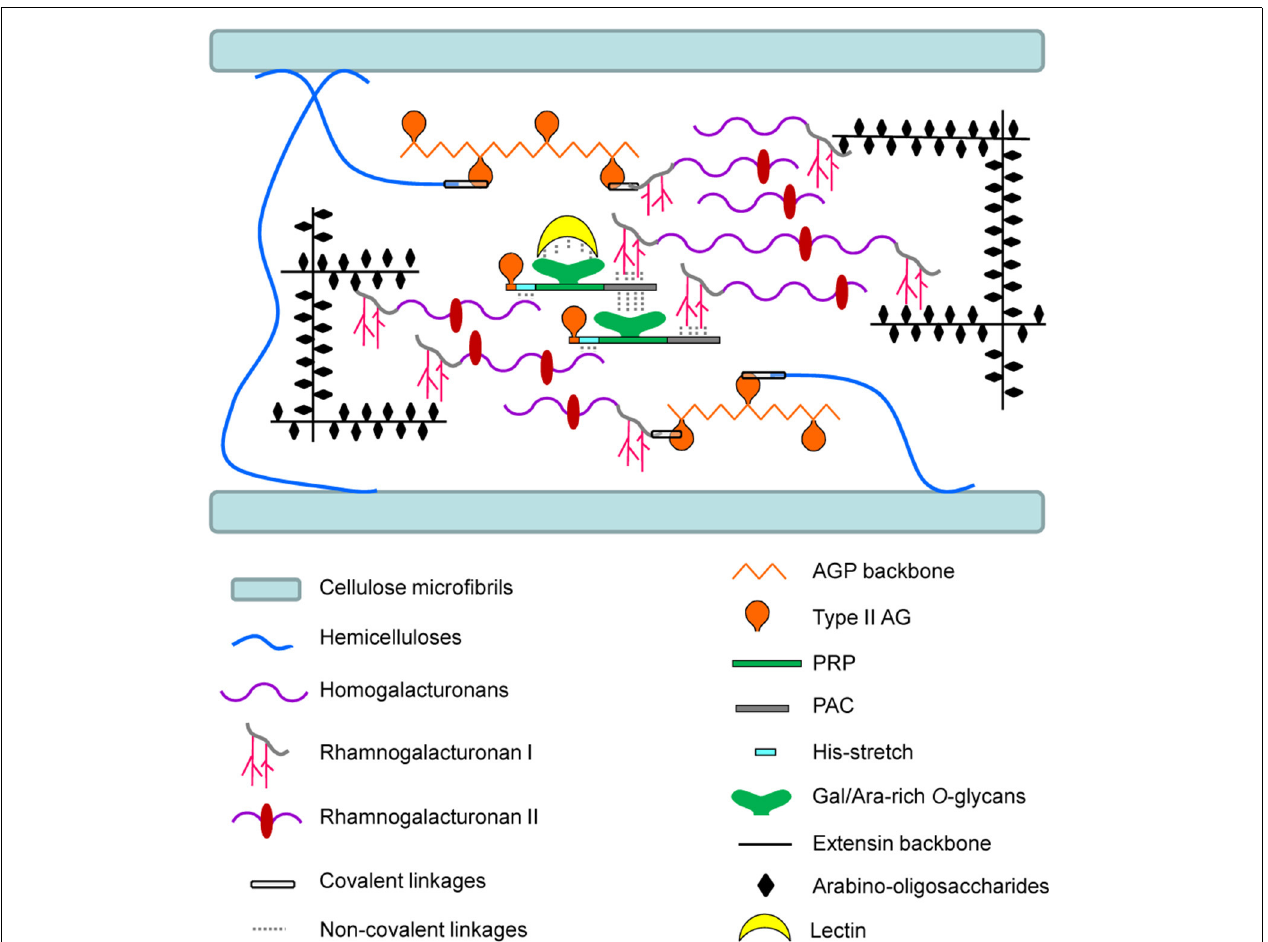
FIGURE 2 | Schematic representation of interactions between HRGPs and cell wall polysaccharides in muro . This model proposes an overview of the interactions assumed or demonstrated between HRGPs and polysaccharides according to most relevant publications in this field. For clarity, the model does not represent the whole complexity of the polysaccharide networks. AGPs are represented with covalent linkages with